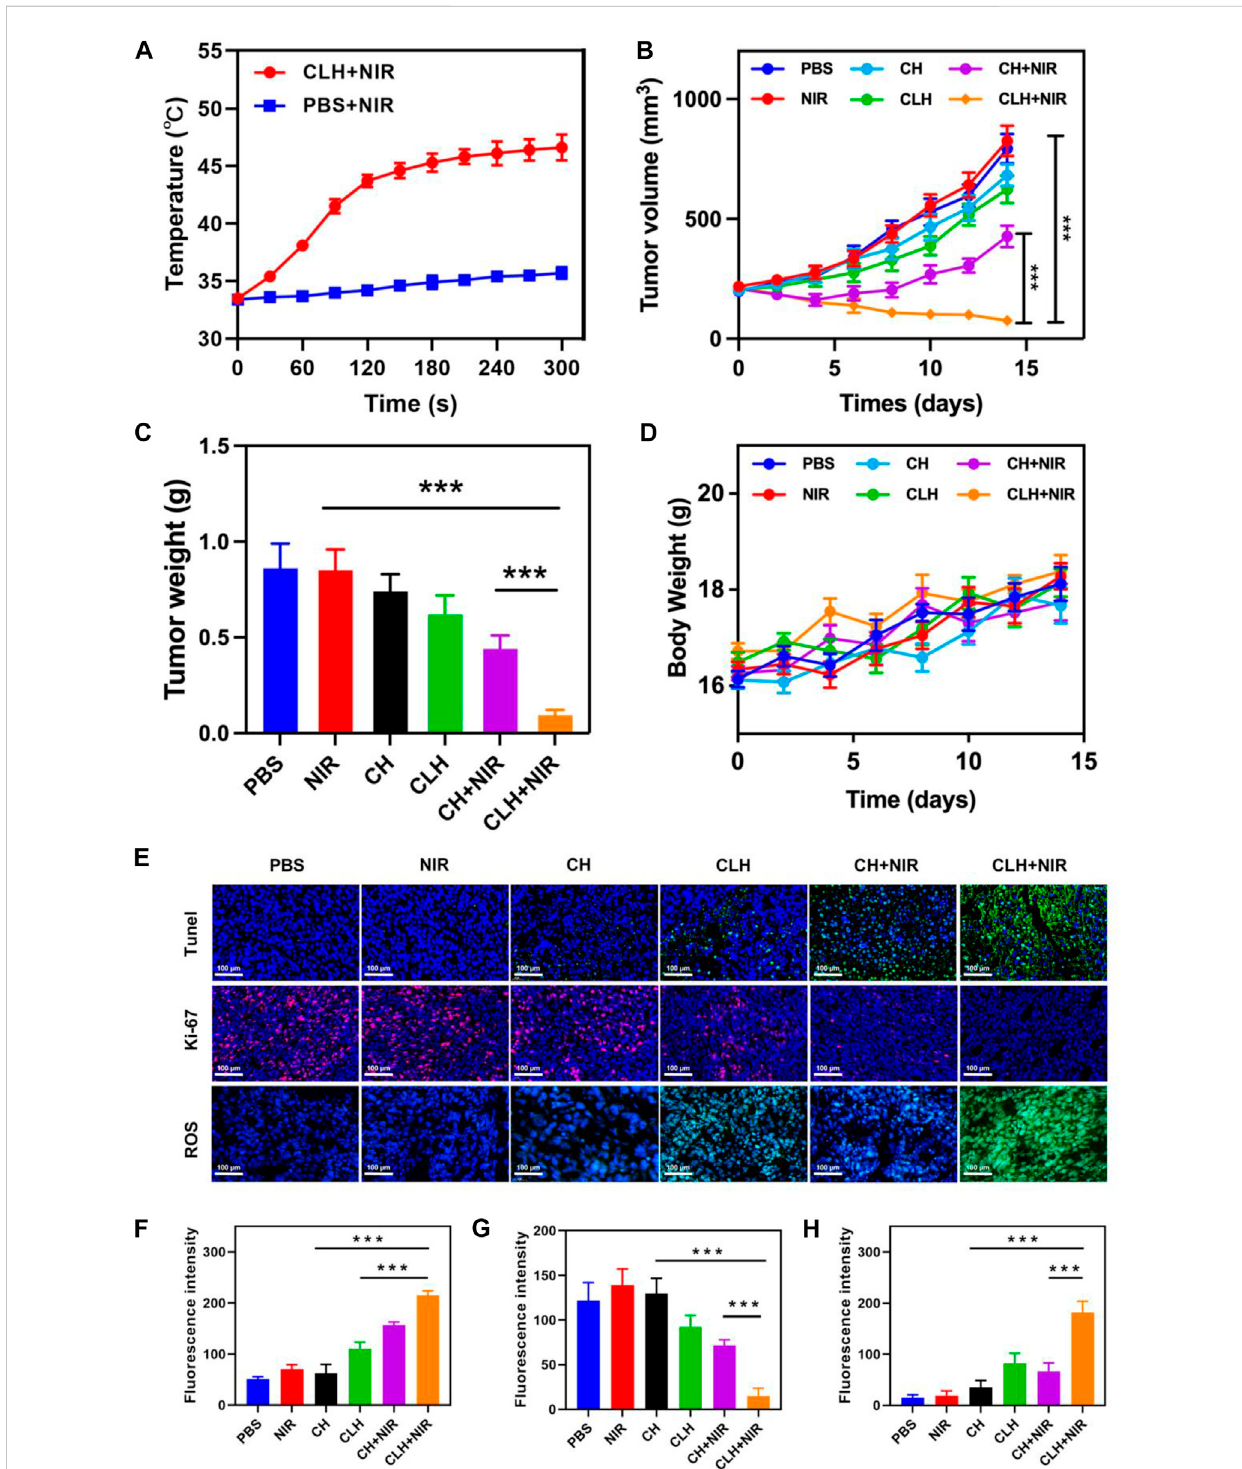
FIGURE 4 (A) Upon being irradiated with 808 nm laser at 0.5 W/cm − 2 for 5 minutes, the temperature elevated in murines having A549 tumor, within speci fi ed treatmentgroups( n =5). (B) Tumor-volumechangecurvesofA549tumor-bearingfemaleBALB/Cnudemurinesfollowingvarioustreatments( n =5). (C) Tumor weight of A549 tumor-bearing female BALB/C nude murines following different treatments ( n = 5). (D) Murine weight changes in different vivo treatments( n =5). (E) TUNEL,Ki-67andROSimmuno fl uorescencestainingintumorregionofeachgrouppost-treatments. (F) TUNEL, (G) Ki-67and (H) ROS fl uorescence